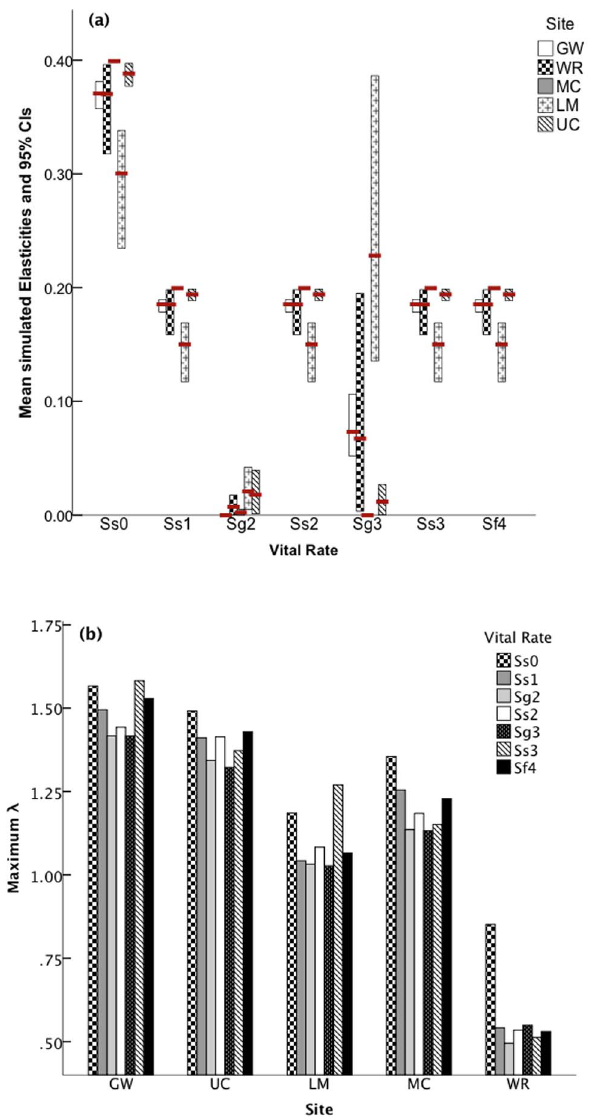
Figure 3. Vital rate elasticities as they relate to population growth rates ( l ) (a) and the maximum possible population growth rate ( l ) obtained when maximizing each vital rate (b), for each site. Red bars represent mean elasticities. See text for vital rate meanings.